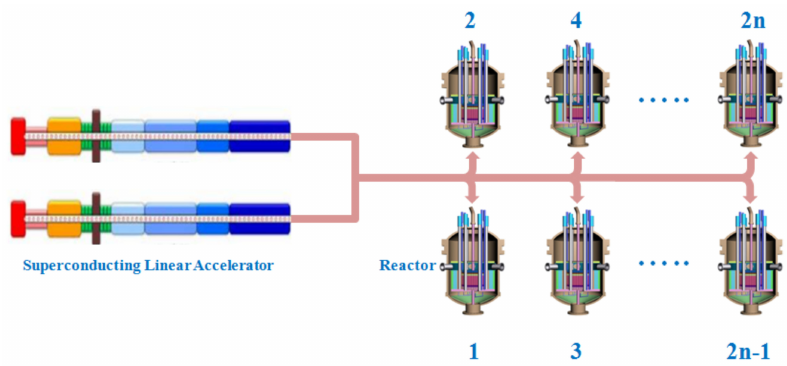
Figure 4. Dual-accelerator’s redundancy mode in